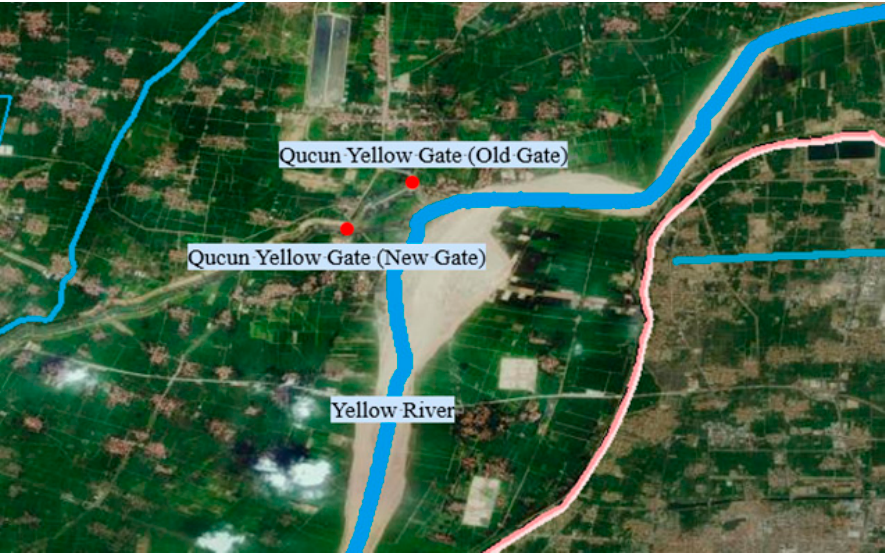
Figure 1. Geographic location of the Yellow River Diversion Gate in Qucun.